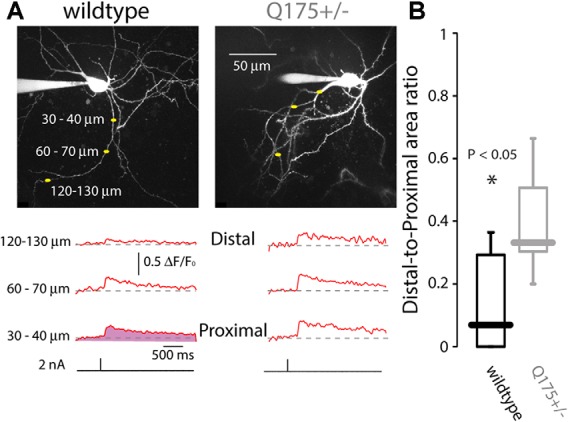
Back-propagating action potentials (bAPs) infiltrate further into distal dendrites of ChIs in Q175 mice, as measured by 2PLSM Ca2+ imaging. (A) Dendritic Ca2+ transients elicited by brief 2 nA somatic current pulses measured at three distances from the soma in wildtype (WT) and Q175+/− mice beneath 2PLSM Z-stacks of the recorded cells. (B) Boxplot of the area beneath the ΔF/F traces (e.g., depicted in the shaded area in bottom left trace) at the distal location divided by the area beneath the ΔF/F traces at the proximal location.